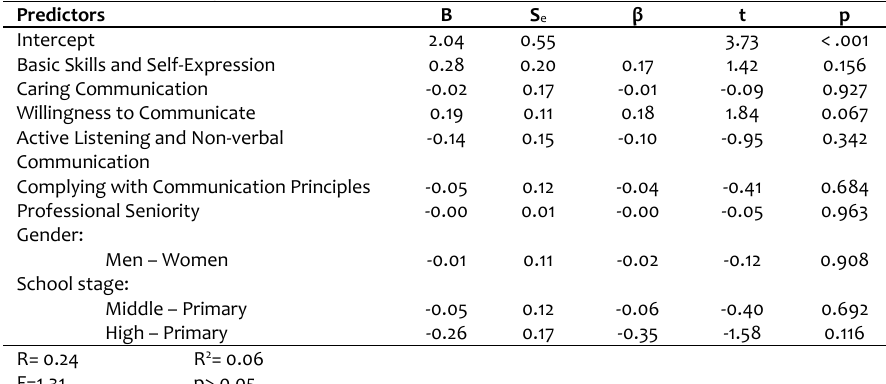
Table 6. Multiple linear regression analysis results for teachers’ level of Laissez-faire